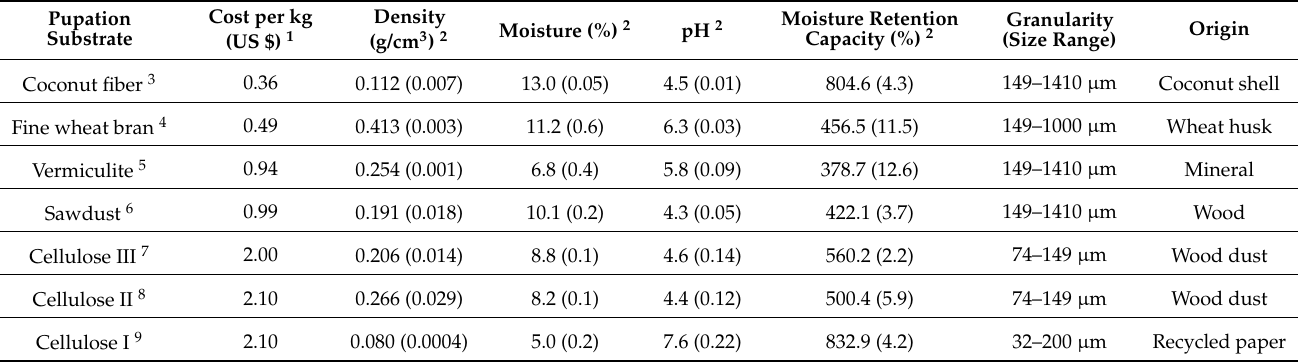
Table 1. The pupation substrates tested with their cost per kg and physicochemical characteristics. Pupation substrates are ordered from the lowest to highest cost per